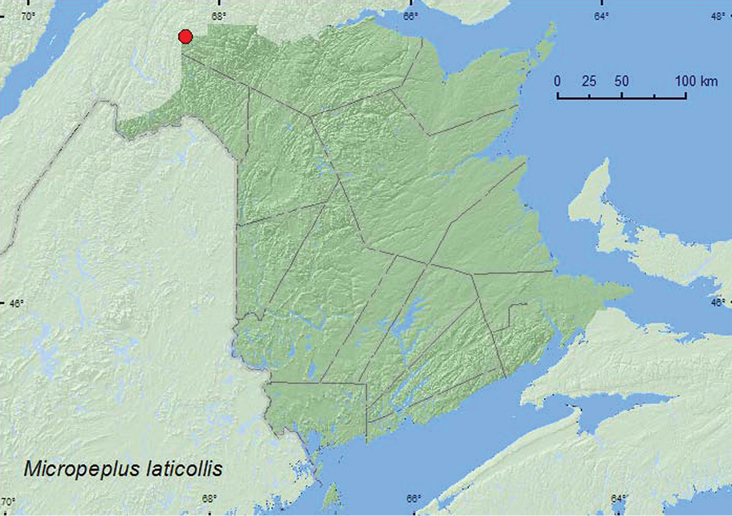
Collection localities in New Brunswick, Canada of Micropeplus laticollis.